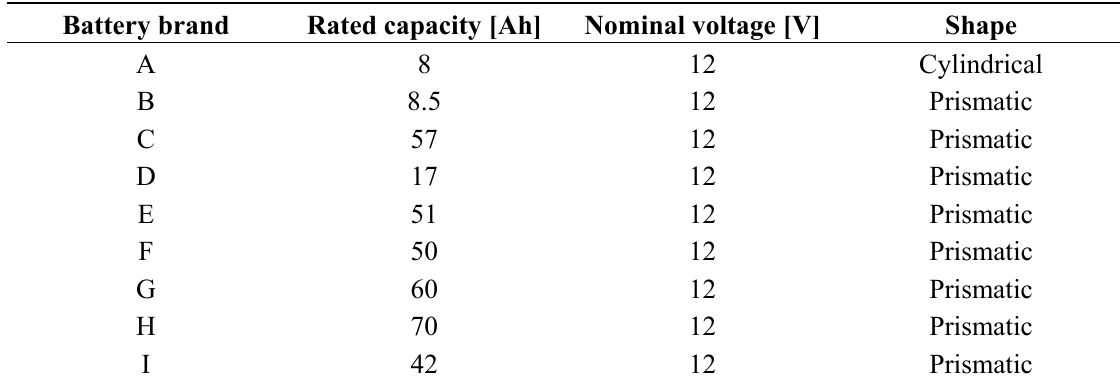
Table 4. Specifications studied VRLA batteries.